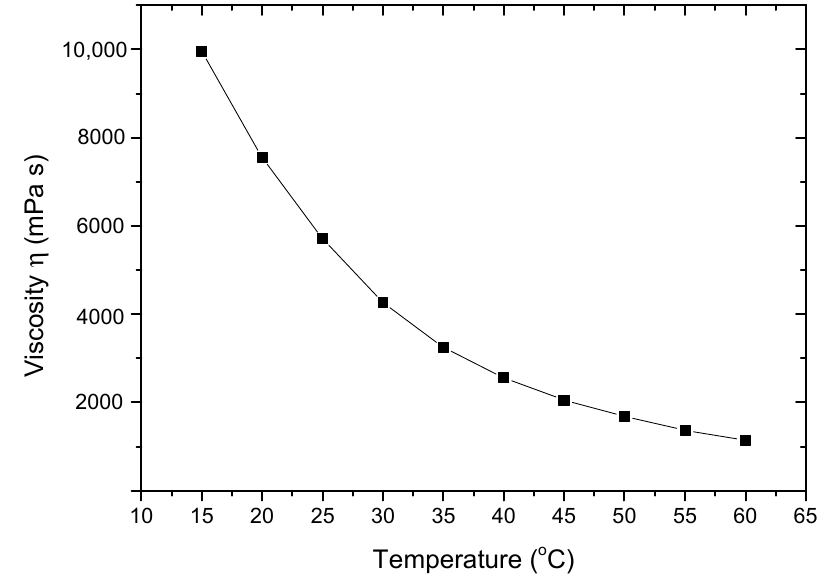
Figure 4. Viscosities of HTPB at different temperatures.